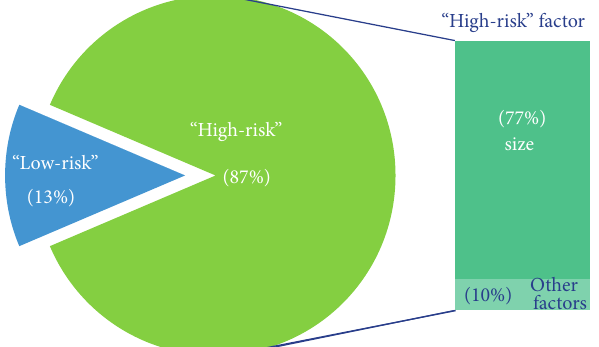
Figure 3: Proportion of “high-risk” versus “low-risk” tumors by NCCN guidelines.